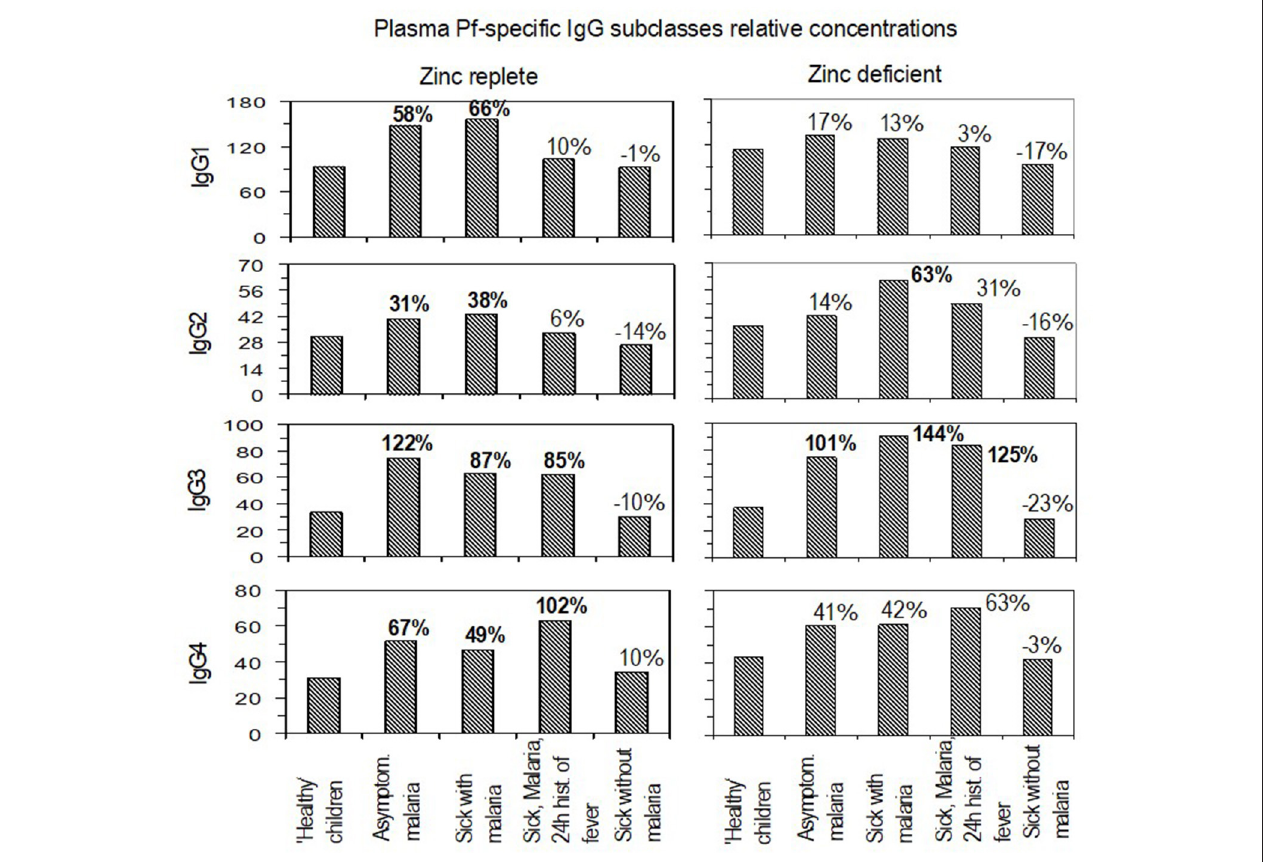
FIGURE 2 | Relative plasma levels and unit change under different malaria and zinc statuses. For each immunoglobulin G subclass, the panels compare the levels in zinc-replete and zinc-deficient situations at different states of malaria infections. Percentages indicate paired group unit change differences in the relative plasma levels of antibodies. Bolded values: significant at p ≤